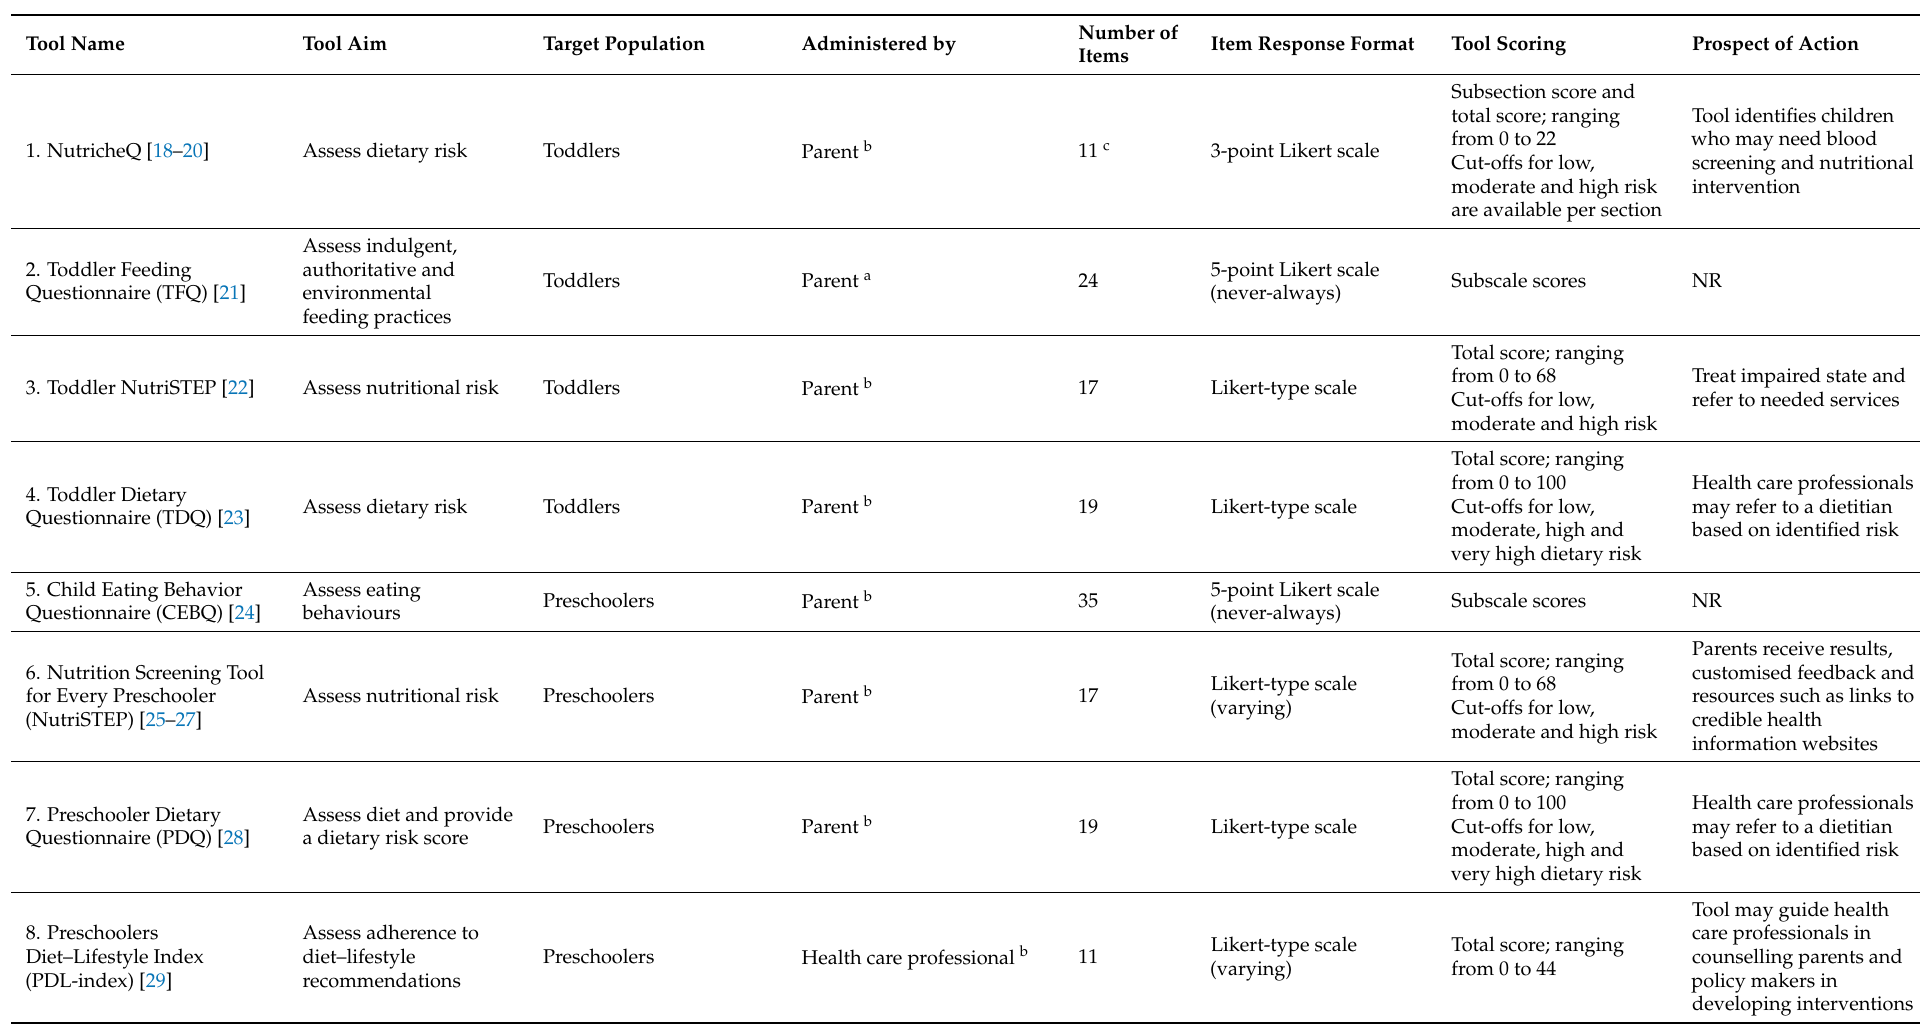
Table 1. Characteristics of lifestyle screening tools for children in the community